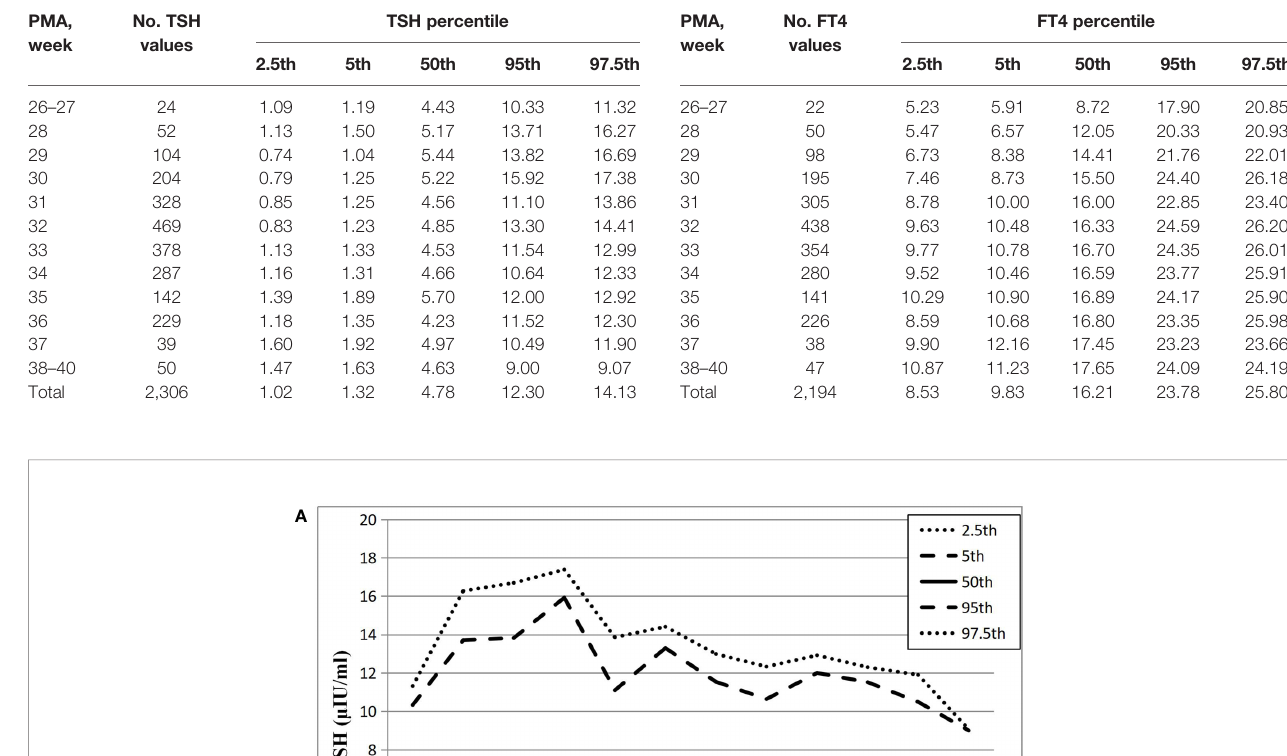
TABLE 2 | Percentiles of TSH values ( m IU/ml) based on different PMA in preterm infants with GA < 32 weeks.